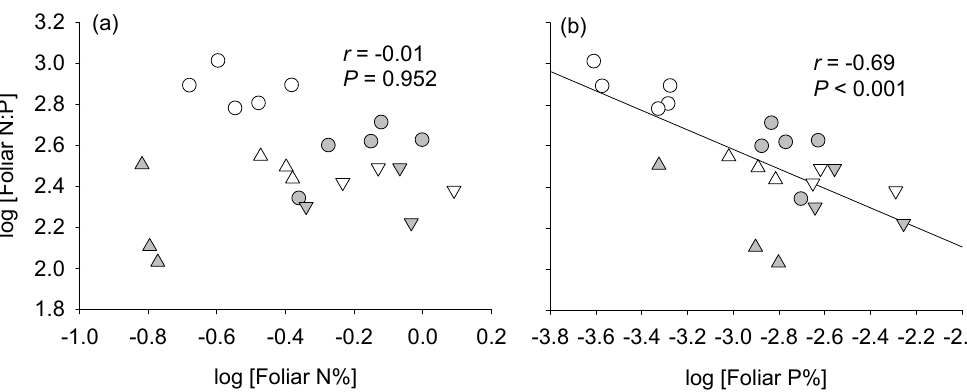
Figure 2. Correlations between ( a ) Imperata cylindrica foliar N content and foliar N:P ratios and ( b ) Imperata cylindrica foliar P content and foliar N:P ratios across the three study sites (Toohey Forest [circles], WRSMCE A [upward triangles], and WRSMCE B [downward triangles]) and across NRF [white-filled symbols] and RFB [grey-filled symbols] areas; Pearson’s correlation coefficient ( r ) and p -values are shown in each panel ( n = 22).